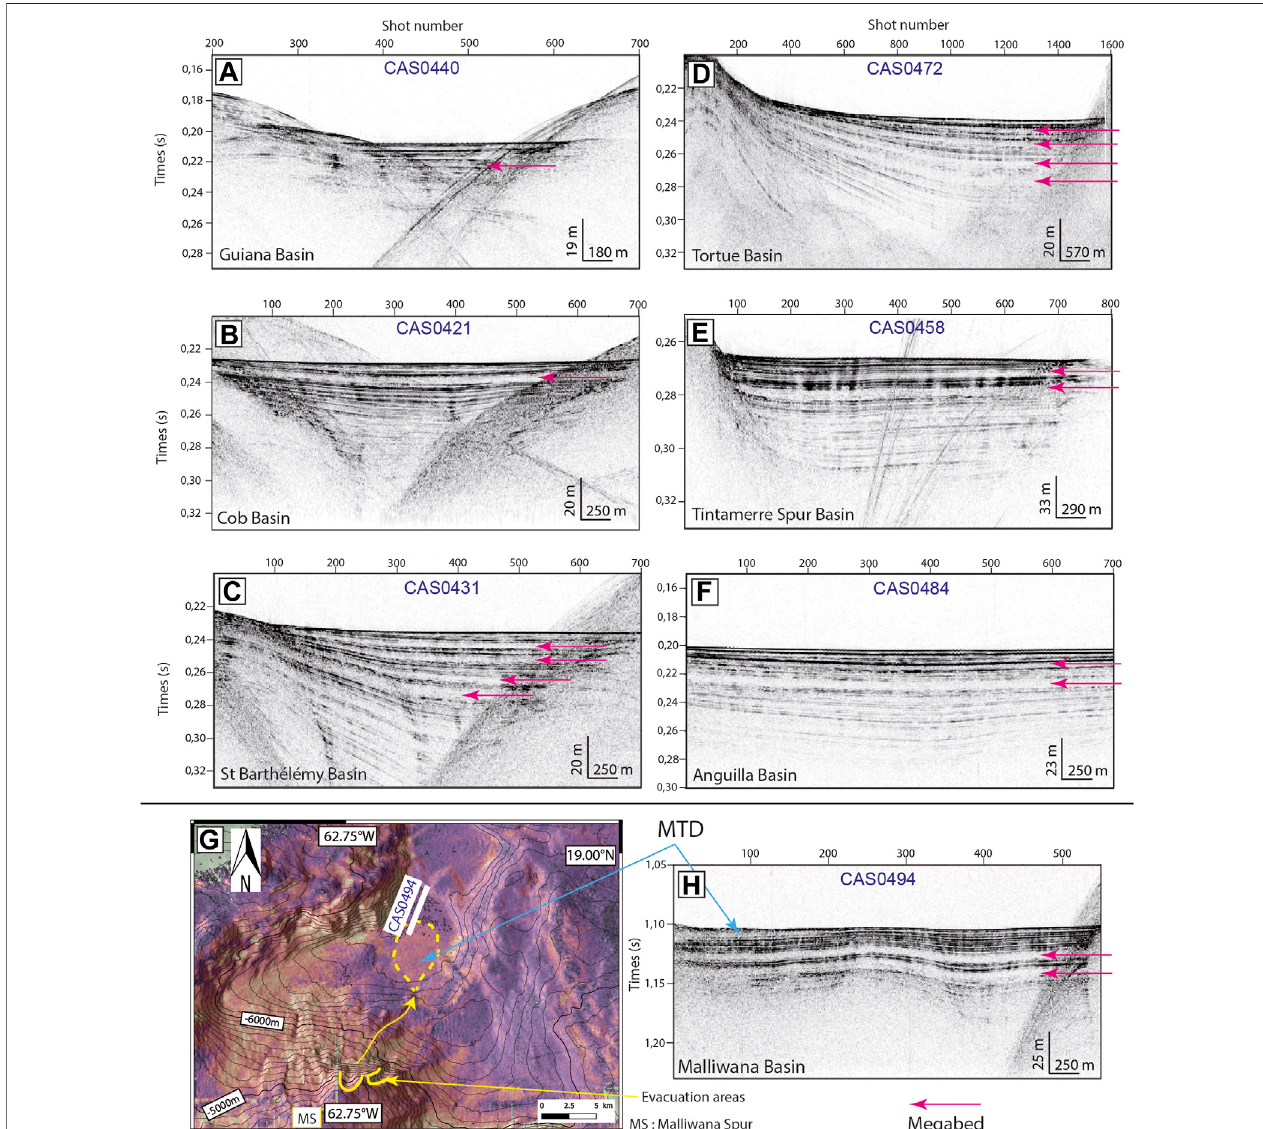
FIGURE 12 | Identi fi cation of thick acoustically transparent units in the sub-bottom pro fi les of the basins. Numerous thick “ acoustic megabeds ” can be identi fi ed but only the most visible are highlighted by the arrows. (A) Guiana Basin. (B) Cob Basin. (C) St Barthélémy Basin. (D) Backscatter map of the Malliwan Basin. Yellow dotted line highlights a MTD. (E) Tortue Basin. (F) Tintamarre Spur Basin. (G) Anguilla Basin. (H) Malliwana Basin. The basins are located in Figures 4 , 13 . MTD: Mass- Transport Deposit.